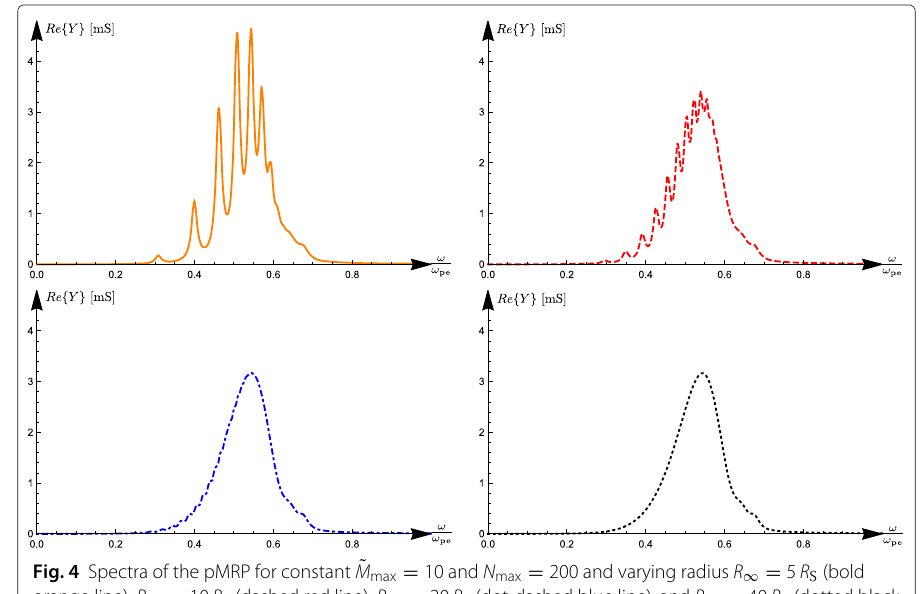
Fig. 4 Spectra of the pMRP for constant ˜ M max = 10 and N max = 200 and varying radius R ∞ = 5 R S (bold orange line), R ∞ = 10 R S (dashed red line), R ∞ = 20 R S (dot-dashed blue line), and R ∞ = 40 R S (dotted black line)